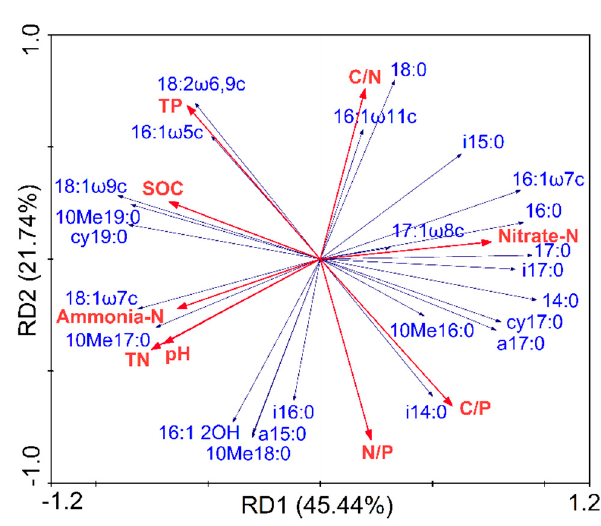
Figure 3. Redundancy analysis (RDA) of relationships between soil microbial community composition and physicochemical properties. The dashed lines with blue color represent the microbial phospholipid fatty acid (PLFA) biomarkers and the solid lines with red color represent the soil physicochemical variables. SOC: soil organic carbon; TN: total nitrogen; TP: total phosphorus; C / N: the ratio of soil organic carbon to total nitrogen; C / P: the ratio of soil organic carbon to total phosphorus; N / P: the ratio of total nitrogen to total phosphorus.